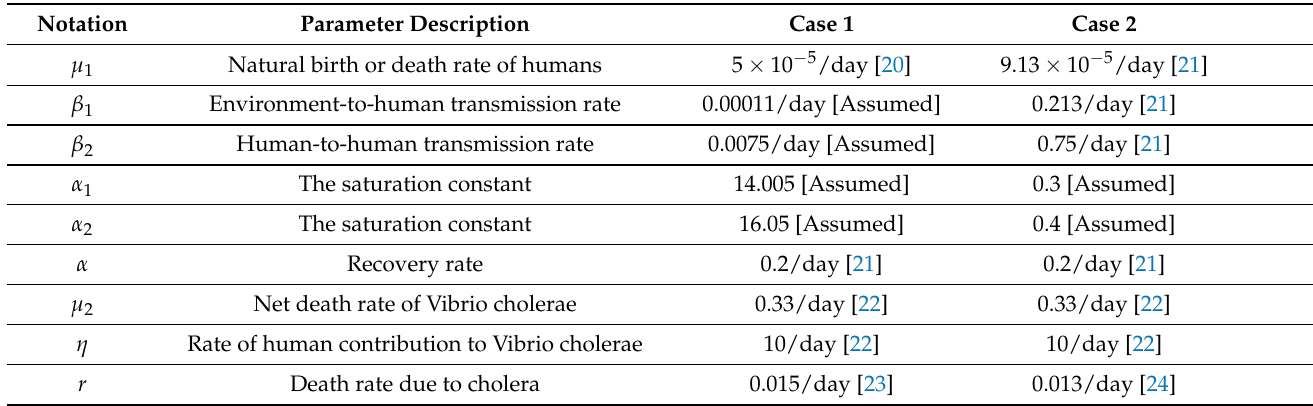
Table 1. Parameter